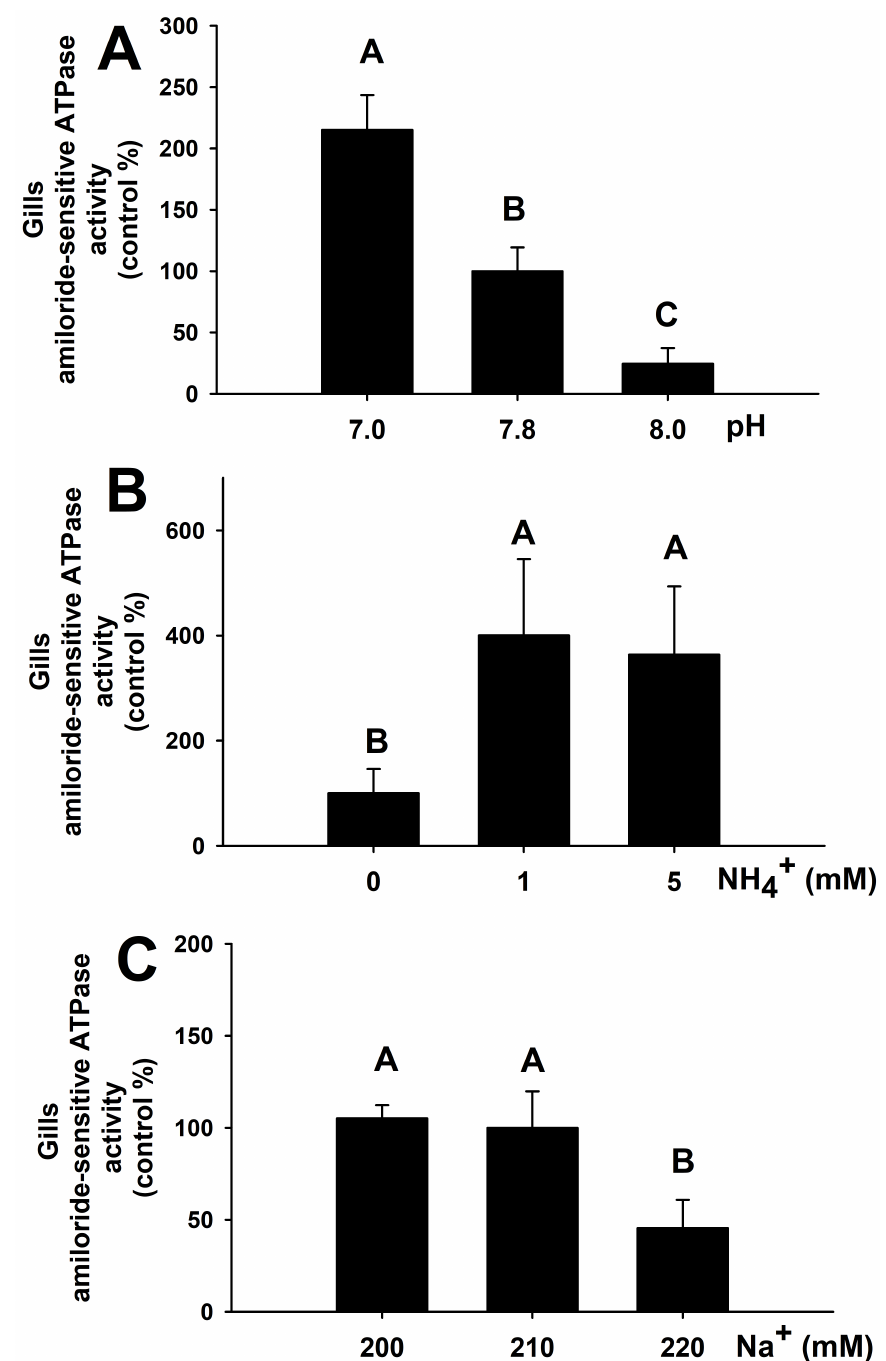
Figure 7. Amiloride-sensitive ATPase activity, putatively associated to a Na + /H + (NH 4+ )-exchanger (NHE) (expressed as control %), in ex vivo gill explants of S. canicula incubated at different pH ( A ), or NH 4+ ( B ) and Na + ( C ) concentrations. Data are expressed as mean ± s.e.m. Different letters indicate significantly different groups ( p < 0.05, n = 8).